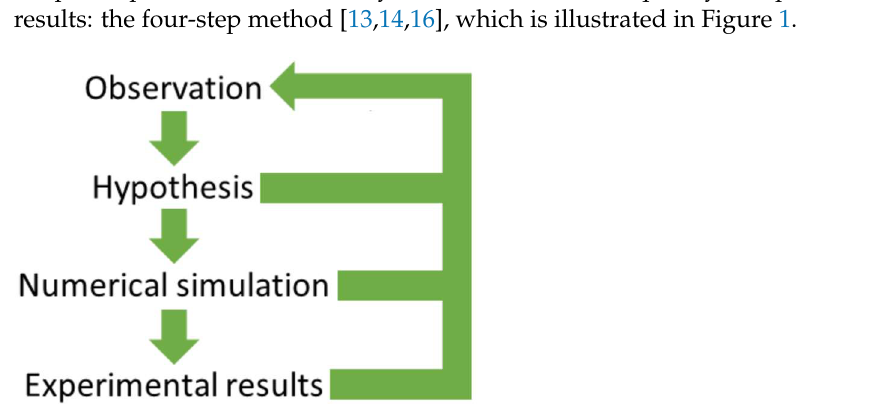
Figure 1. Schematic representation of the methodological approach used to investigate the genesis of the US signs, which are observed on lung US images in the presence of pulmonary pathologies.